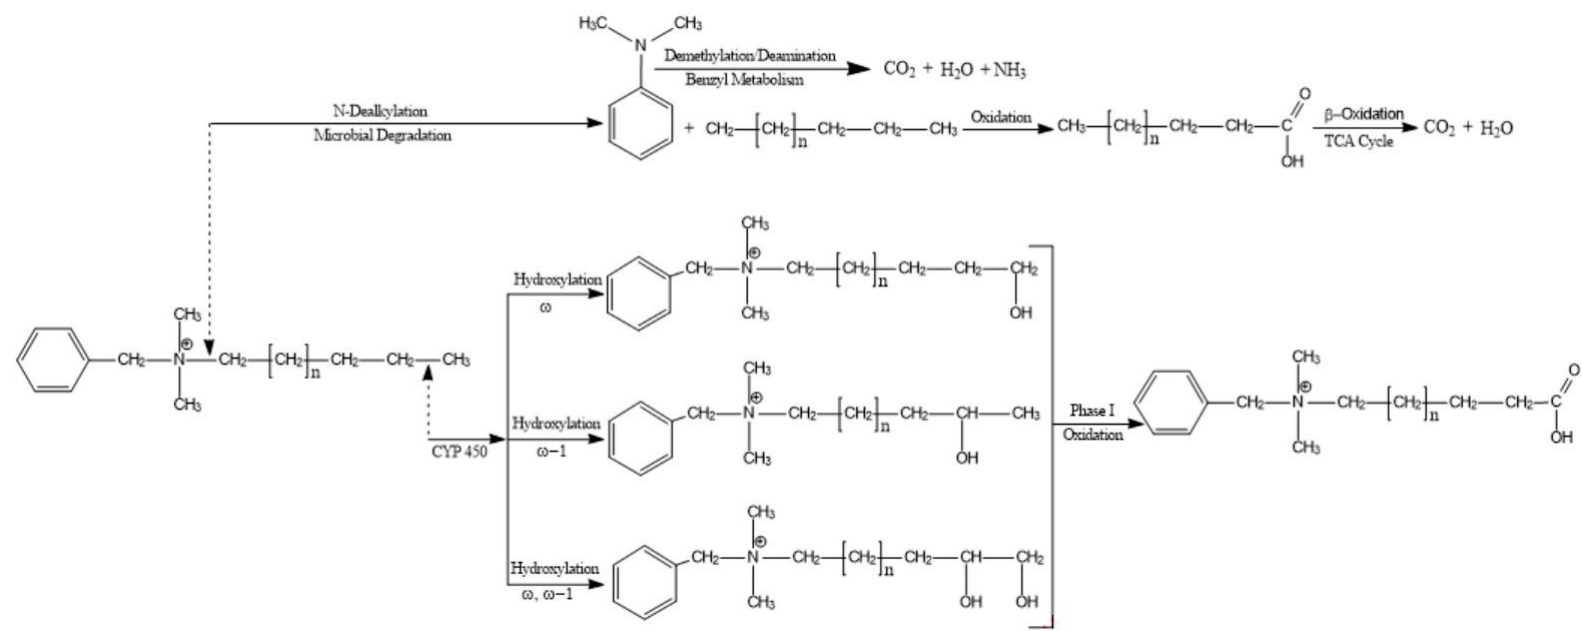
Figure 8. Benzalkonium chloride ( n = 6, 8 and 10) metabolism scheme (adapted from references [285,288,290]).